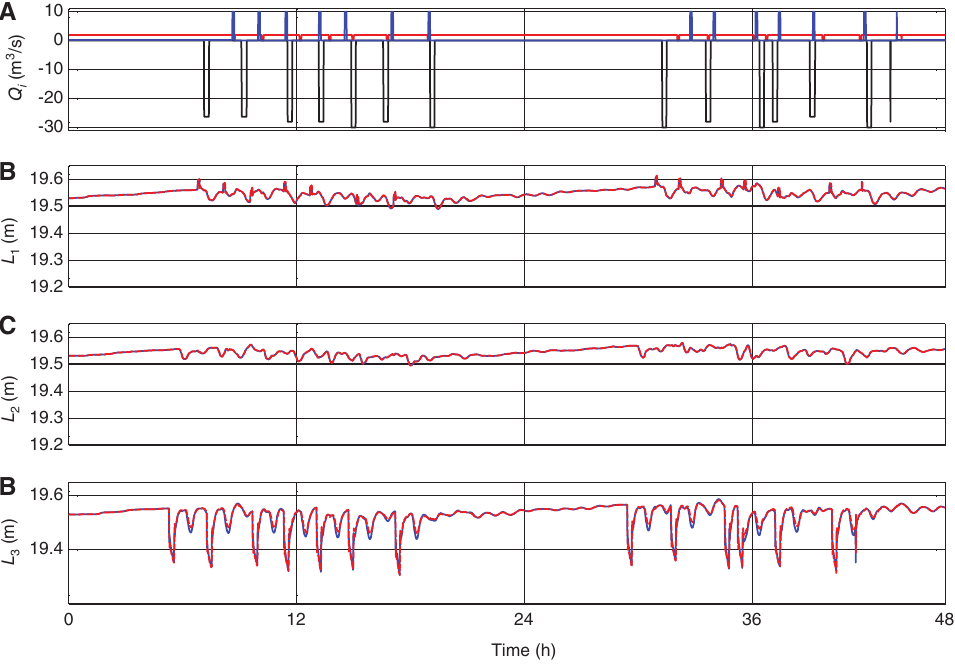
Figure 13. Scenario 3 of Two Navigation Days with the Cuinchy Lock and Fontinettes Lock Operations. (A) Discharges in Cuinchy (Blue Line), in Aire-sur-la-Lys (Red Line), and in Fontinettes (Black Line). Estimated (Red Dashed Line) and Measured (Blue Con- tinuous Line) Levels at (B) Cuinchy L , (C) Aire-sur-la-Lys L , and (D) Fontinettes L . 1 2 3